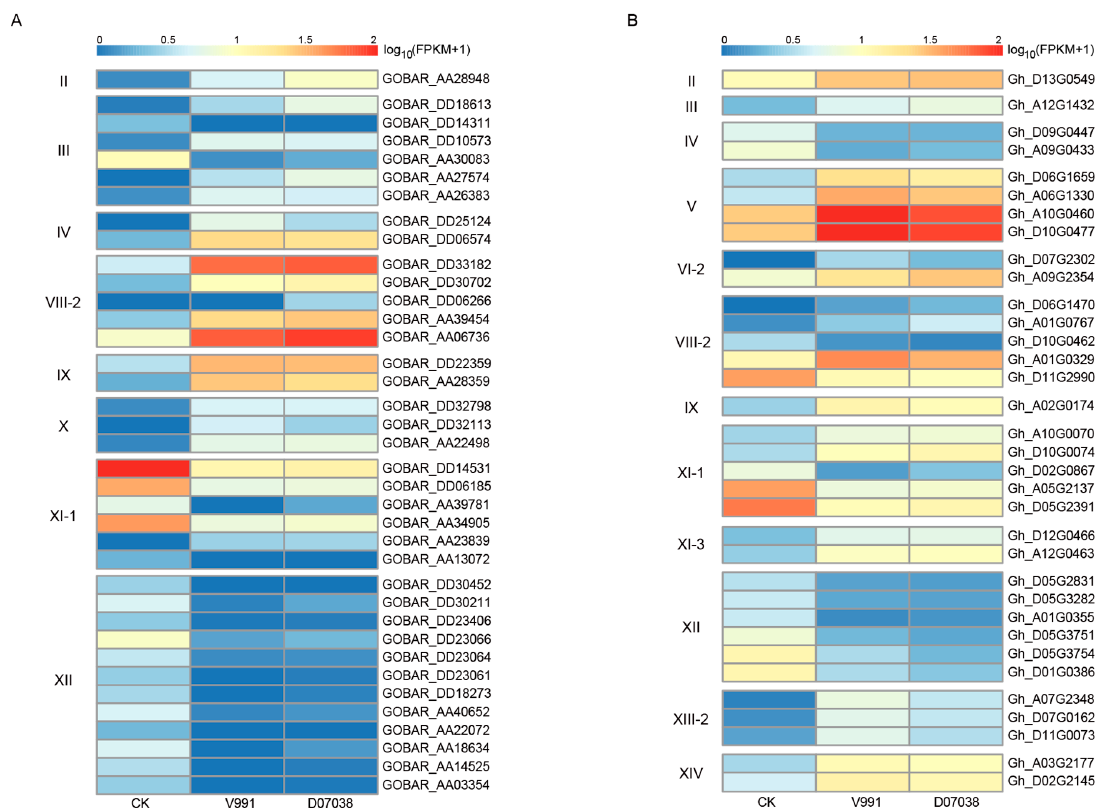
Figure 8. Expression patterns of differentially expressed LRR-RLK genes in response to Verticillium dahlia infection. For both G. barbadense ( A ) and G. hirsutum ( B ), significant differentially expressed LRR-RLK genes simultaneously detected in both samples infected with V. dahliae strain V991 (highly toxic) and samples infected with V. dahliae strain D07038 (intermediately toxic) were used for heatmap drawings for each subfamily.